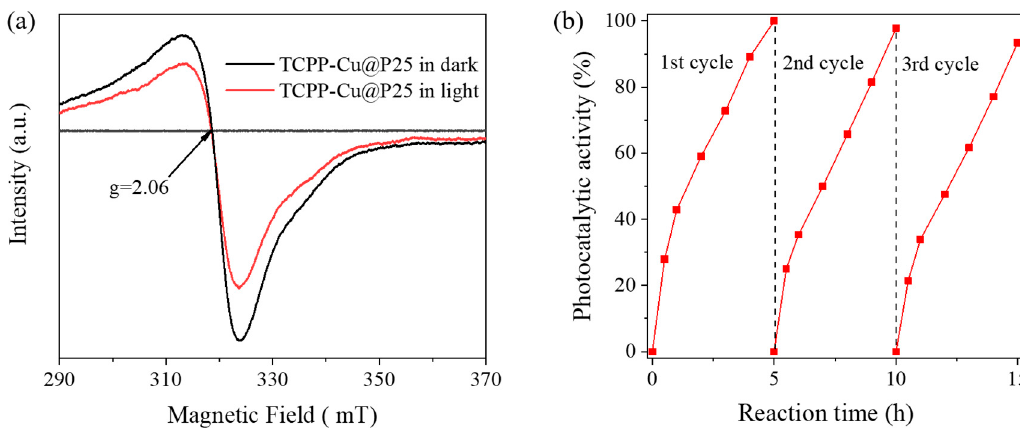
Figure 4. ( a ) ESR spectra of TCPP-Cu@P25 with (red curve) and without (black curve) light irradiation; ( b ) long-term course of CO evolution from CO 2 reduction over TCPP-Cu@P25 (50 mg) under Xe lamp